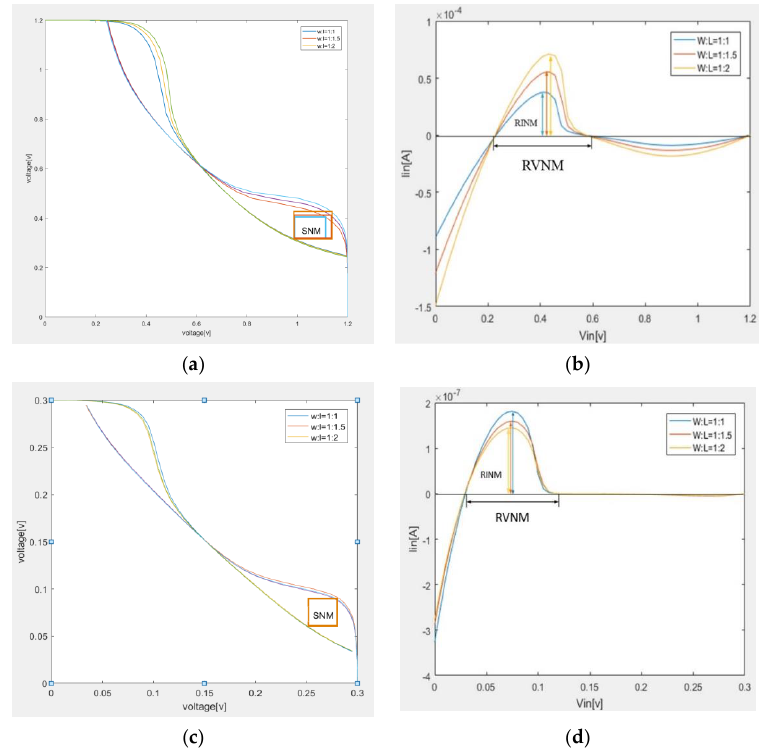
Figure 7. ( a ) Static stability at 1.2 V; ( b ) stability of leakage current at 1.2 V; ( c ) static stability at 0.3 V; ( d ) and stability of leakage current at 0.3 V. Table 1. Comparison of stability and static stability based on leakage current.